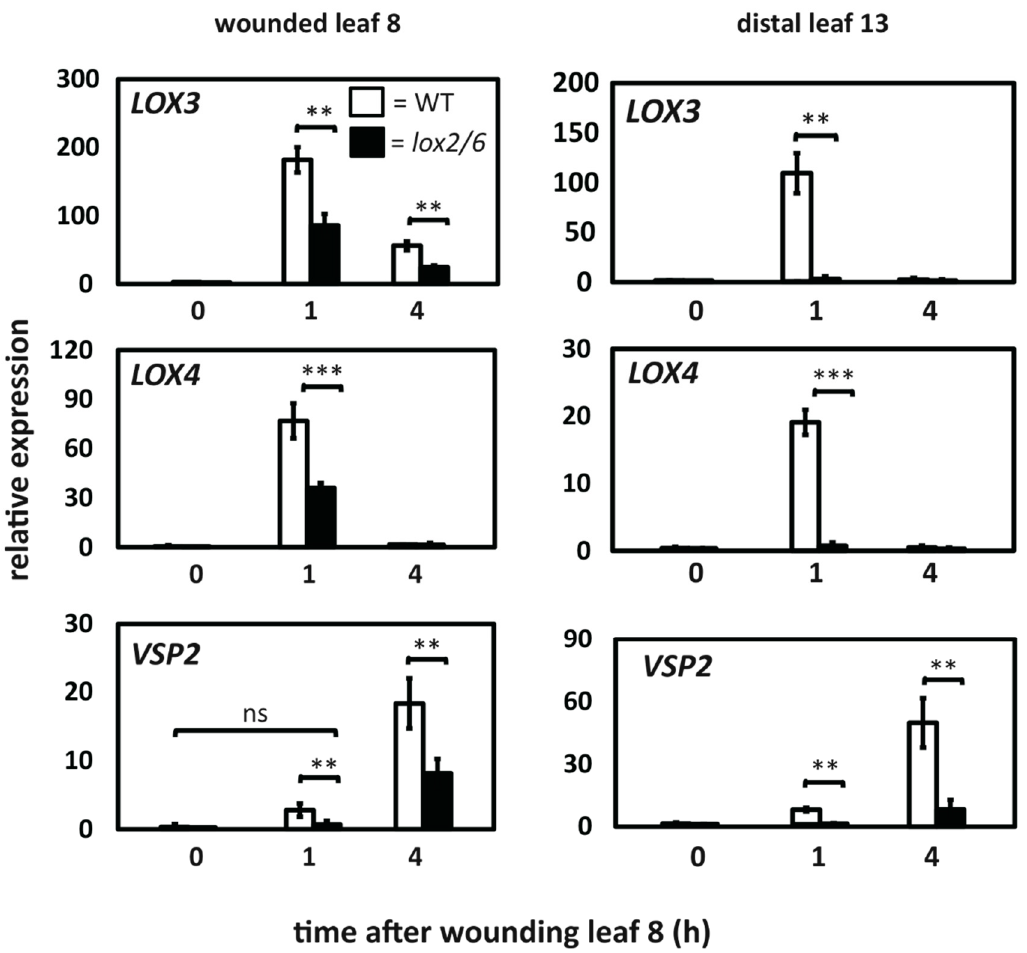
Figure 4. Wound-inducible LOX3 , LOX4 , and VSP2 expression in WT (open bars) and the lox2-1 lox6A double mutant (black bars). Leaves 8 (wounded) and 13 (distal) were snap-frozen before and after wounding. Data are from three to four biological replicates (±SD). Data from a 2h timepoint also included in the original experiment are not shown. Asterisks refer to data significantly different from WT (ns: not significant; *, p < 0.05; **, p < 0.01, and ***, p < 0.001; t -test).